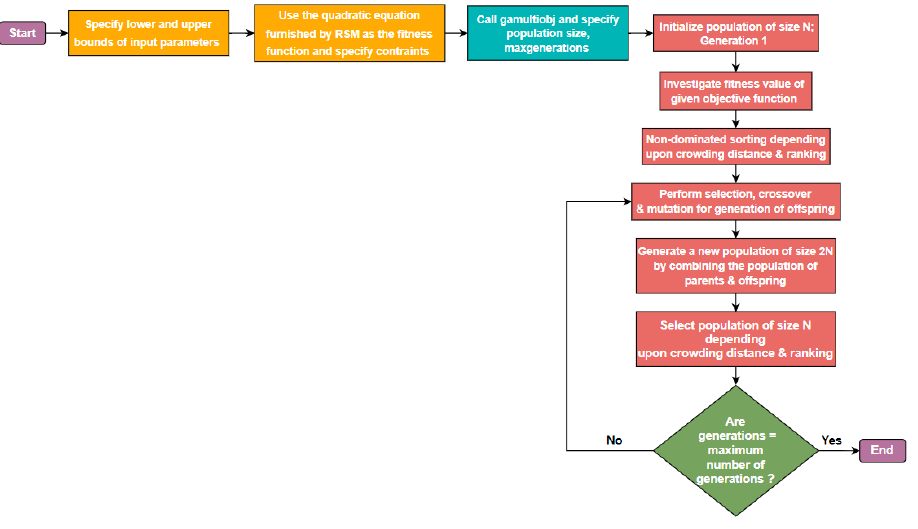
Figure 8. Flowchart for the hybrid RSM and NSGA-II approach.